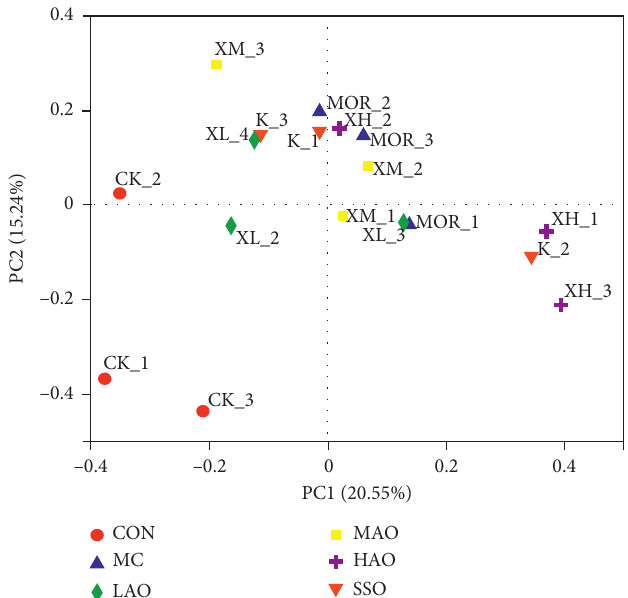
Figure 9: Principal coordinate analysis (PCoA) between different groups.